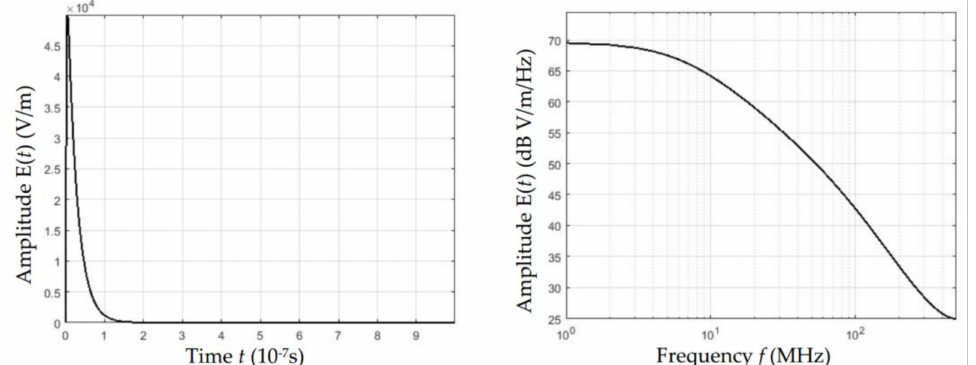
Figure 5. Time-domain and frequency-domain waveforms of the HEMP radiation field with E = 1